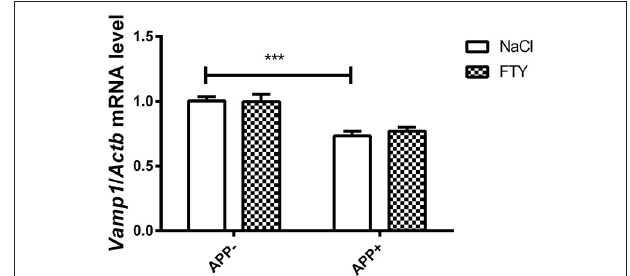
FIGURE 1 | Levels of mRNA coding for synaptic protein VAMP1 in 3-month-old mouse cortex–effect of A β PP expression and FTY720 administration. Levels of mRNAs measured with real-time PCR in the cerebral cortex of 3-month-old (adult) mice as described in Materials and methods. Results from A β PP-expressing mice were compared with those from control animals that did not inherit the transgene. Effect of FTY720 administration was assessed against vehicle-treated animals of the same group. Vamp1 , vesicle-associated membrane protein 1; APP − , animals without V717I A β PP transgene; APP + , mice expressing V717I A β PP transgene. *** p < 0.001 vs. corresponding controls, two-way ANOVA followed by Tukey’s post-hoc test (significances marked over the horizontal bar describe the difference between vehicle-treated control animals and vehicle-treated A β PP-expressing mice). n = 6–7, measured in tri- to quadruplicate ±